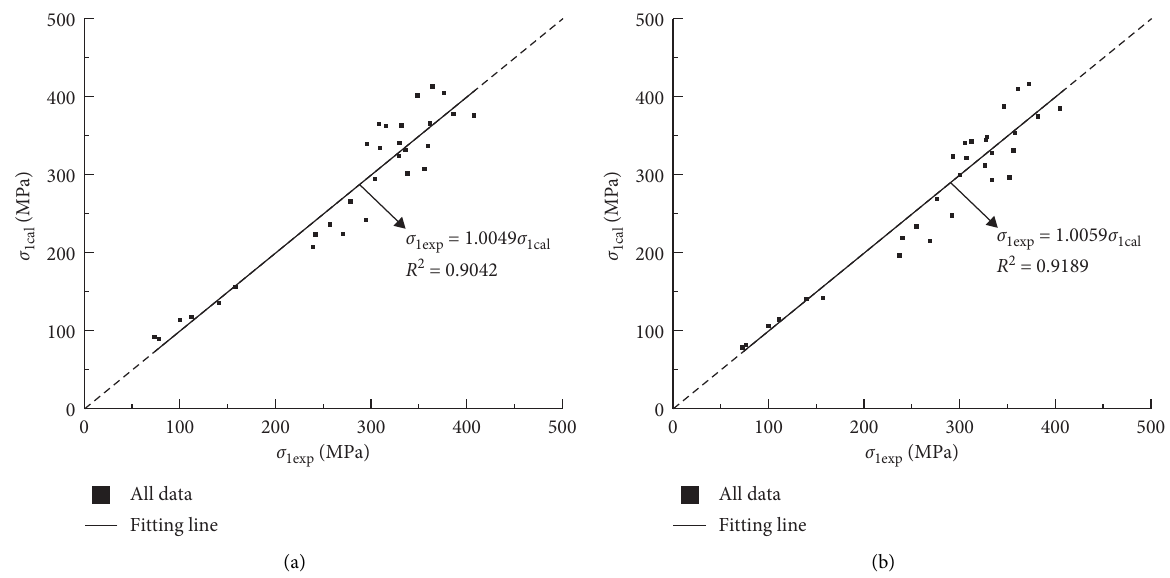
Figure 5: The fitting results of all the experimental strength of jointed marble: (a) the linear Mogi–Coulomb failure criterion and (b) the proposed failure